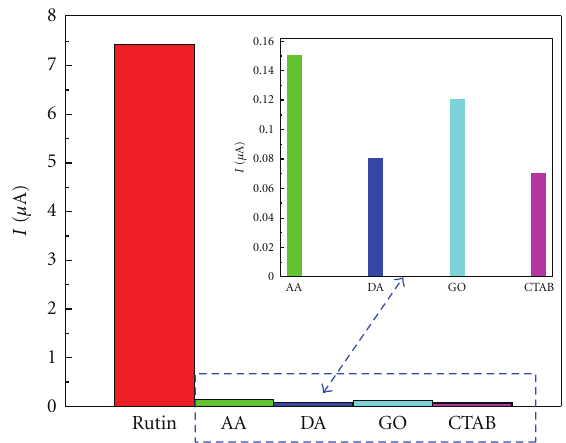
Figure 5: Comparison of DPV currents of 1.0 × 10 − 6 M rutin with 1.0 × 10 − 3 M outer species in 0.1 M pH 5.0 phosphate bu ff er solution. The inset is to present other column with lower resolution on y